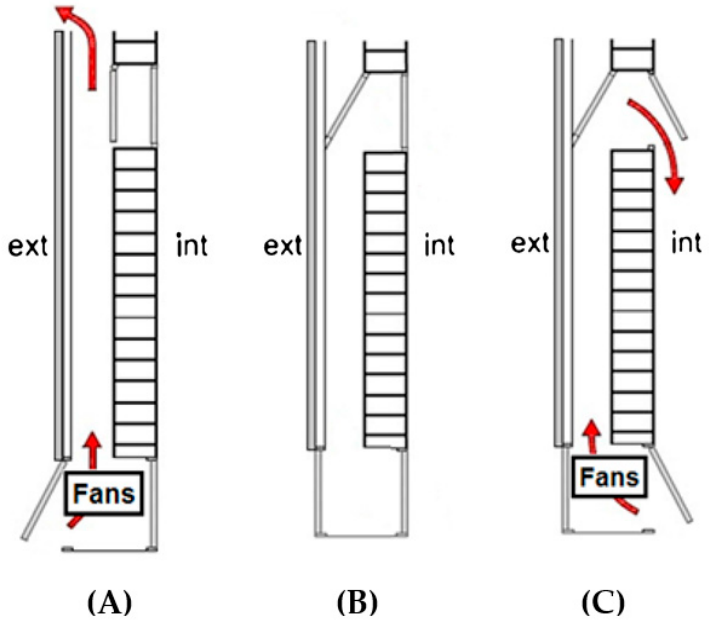
Figure 23. Operation of ventilated façade in modes of ( A ) charging process, ( B ) storage, and ( C ) discharging processes [188].